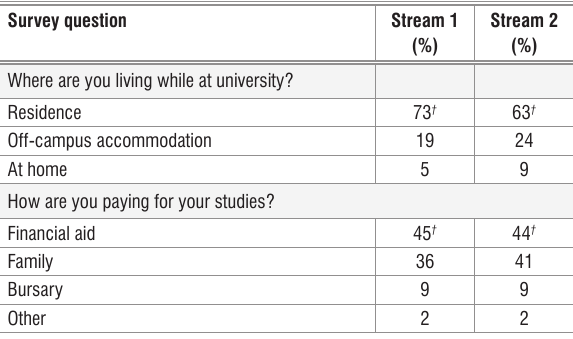
Table 3: Student responses to questions about their university